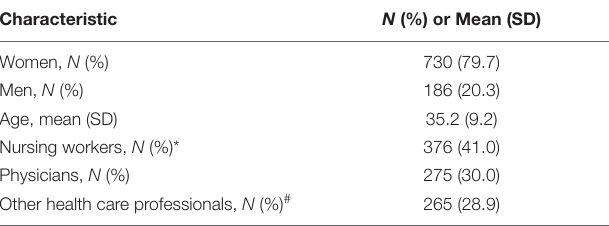
TABLE 1 | Characteristics of participants ( N =